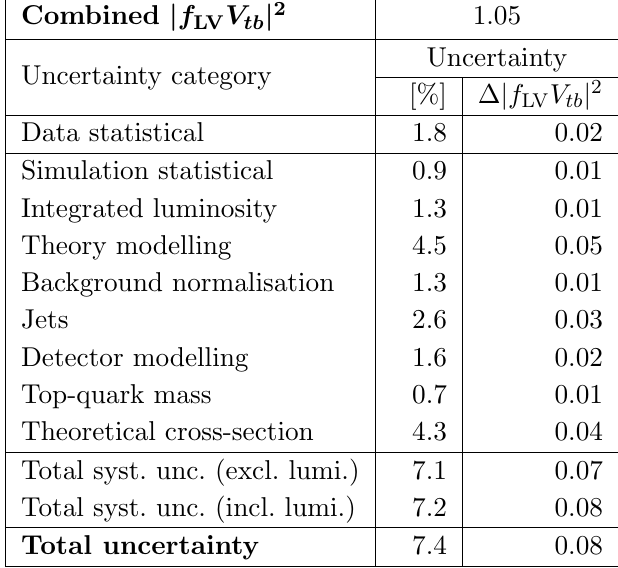
Figure 3 . Correlation matrix of the overall measurement in a given production mode, experiment, and at a given centre-of-mass energy.